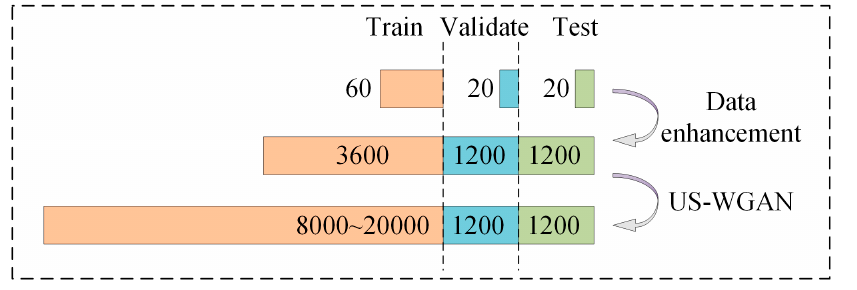
Figure 7. Data-set structure for virtual defect and US-WGAN data enhancement methods.